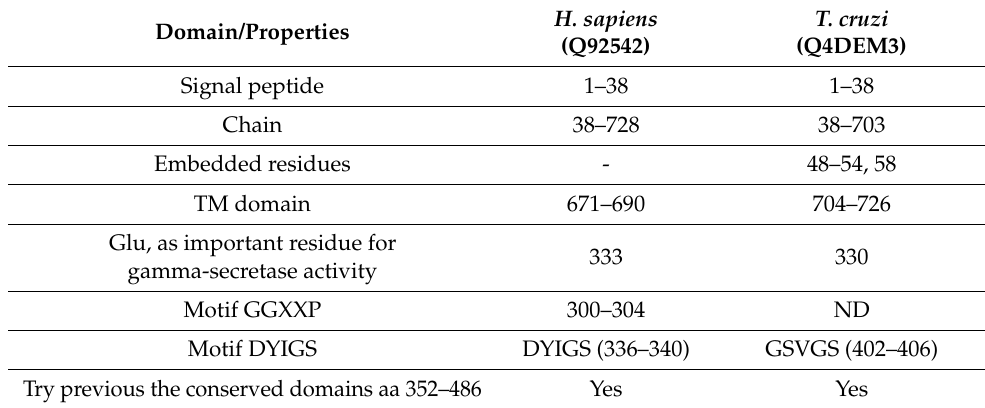
Table 2. Comparison of domains and properties within T. cruzi and human cells NICT